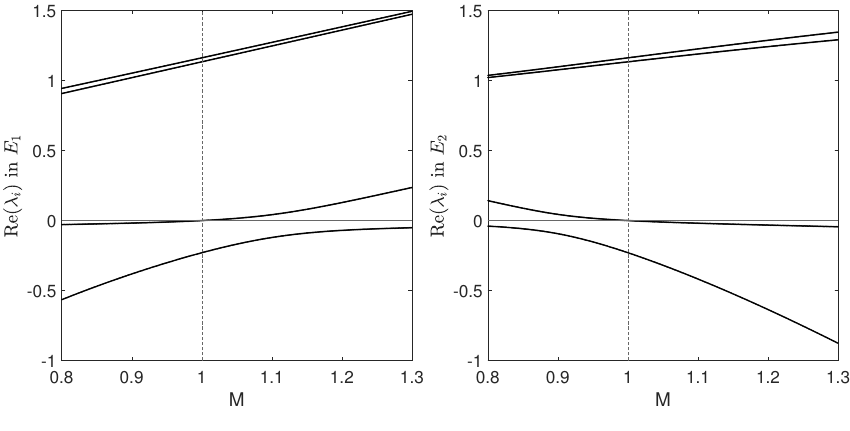
Figure 2. Zoom of the reference case described in Figure